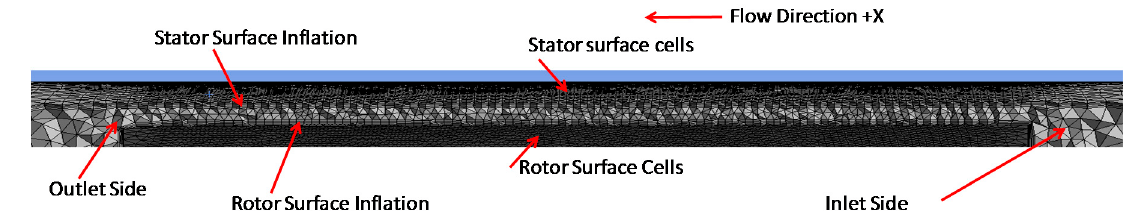
Figure 11. CFD numerical grid prism inflation layers in narrow gap region.